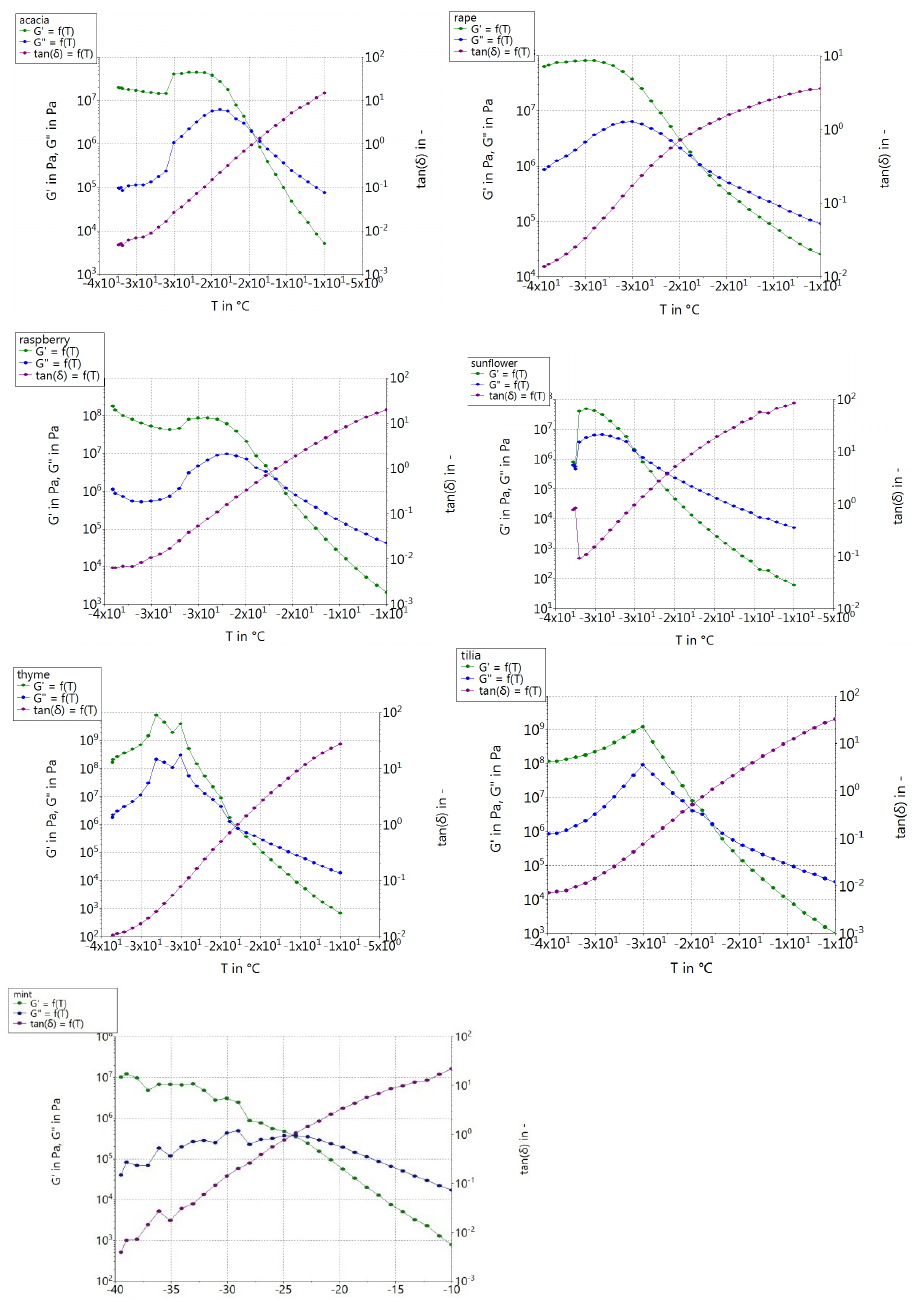
Figure 2. Rheological behaviors of acacia, rape, raspberry, sunflower, thyme, tilia and mint honey in negative temperatures.